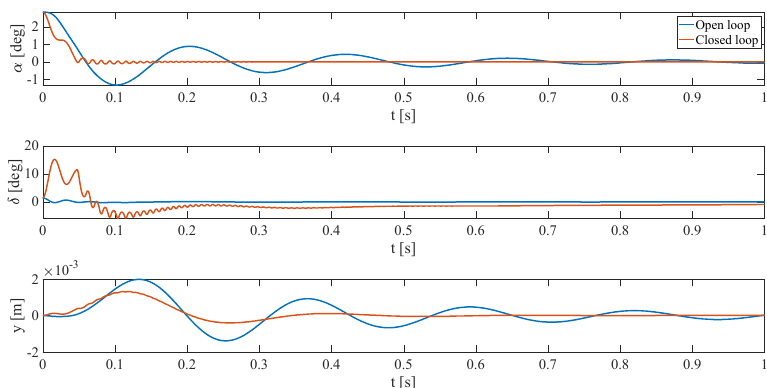
Figure 17. Magnification of the transient responses to the linear velocity variation.